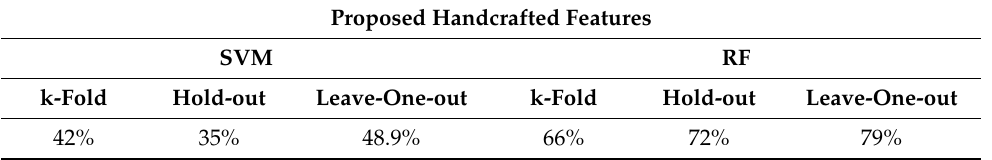
Table 8. The comparison of the proposed handcrafted features with different state-of-the-art tech-